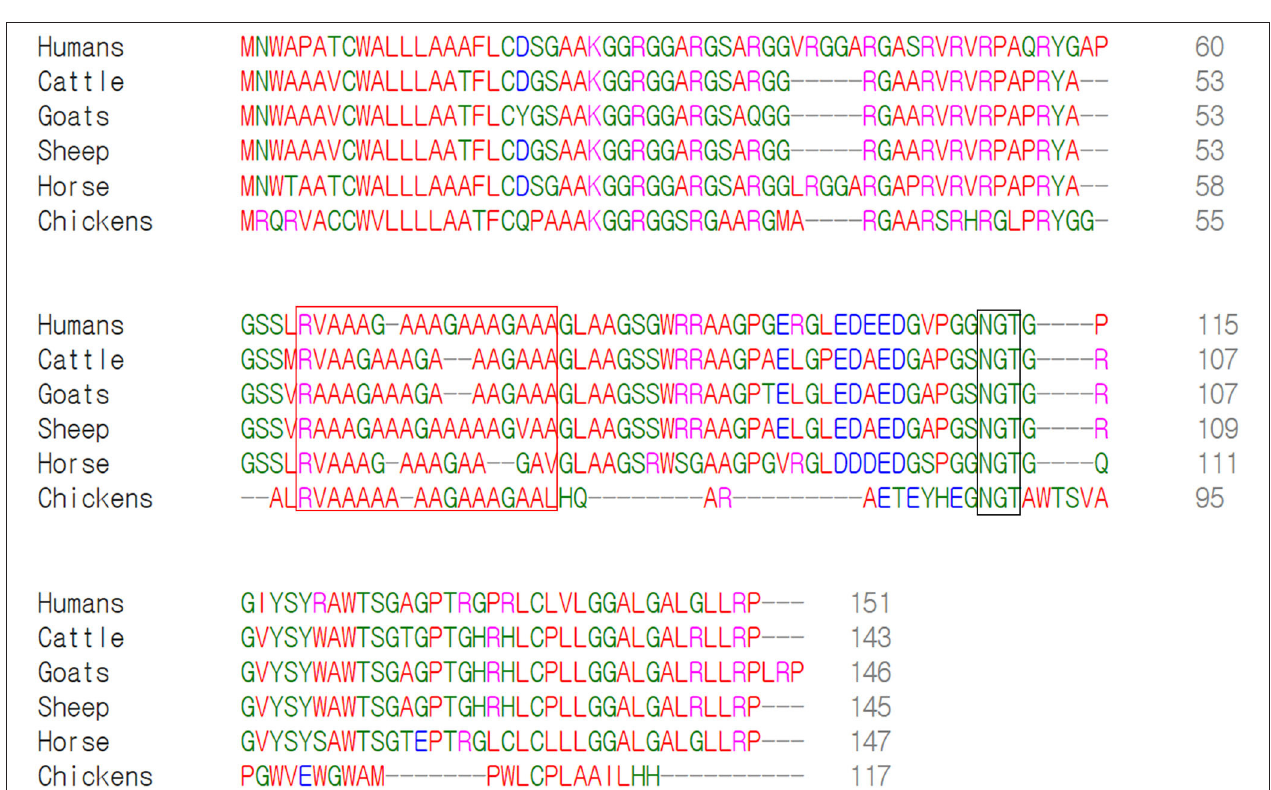
FIGURE 2 | Multiple sequence alignments of amino acid sequences of the shadow of prion protein (Sho) in humans, cattle, goats, sheep, horses and chickens. Colors indicate the chemical properties of amino acids; blue: acidic; red: small and hydrophobic; magenta: basic; green: hydroxyl, sulfhydryl, amine and glycine. The red box indicates the interaction region of Sho with prion protein (PrP). The black box indicates the NXT glycosylation motif of Sho.